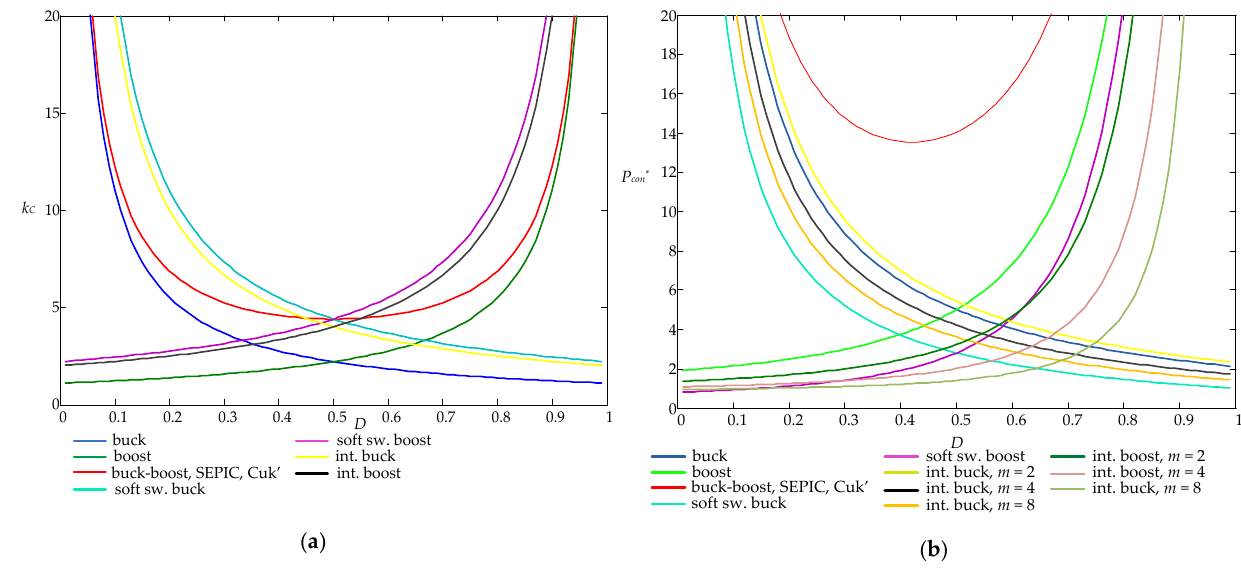
Figure 10. DC – DC converters: ( a ) cost factor k C ; ( b ) normalized power loss P con * .